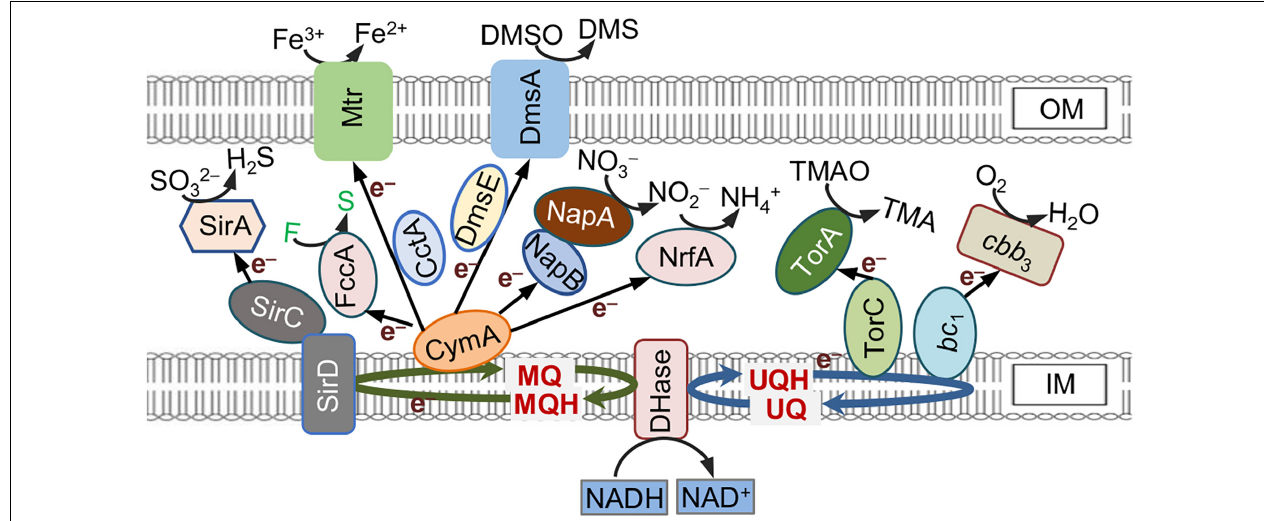
FIGURE 1 | c -Type cytochrome (c-Cyt)-involved extracellular electron transfer (EET) pathways in Shewanella oneidensis . Electrons generated from oxidation of electron donors are conserved in NADH and fed into the quinol pool composed of menaquinone (MQ) and ubiquinone (UQ), which link to different quinol oxidases. CymA, the predominant quinol oxidase for EET via Mtr, is promiscuous for electron acceptors (EAs). This promiscuity is a likely cause of low EET efficiency. Proteins whose names are in black are c -Cyts whereas in white are not. F, fumarate; S, succinate.